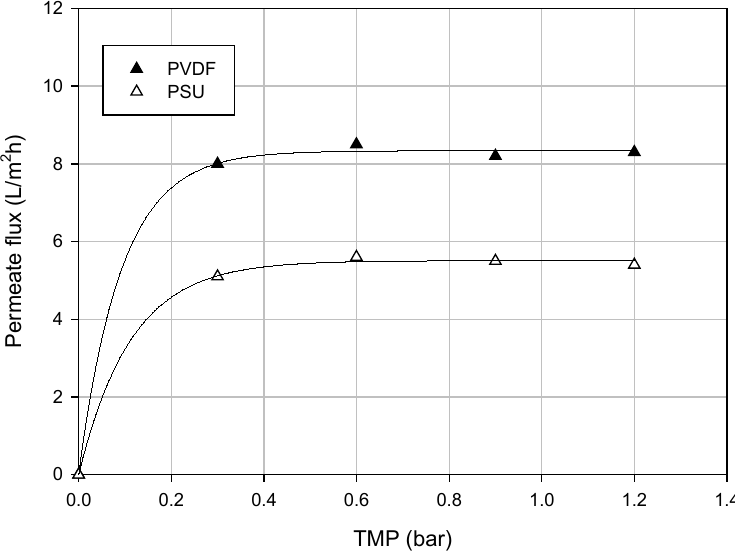
Figure 2. Permeate flux as a function of transmembrane pressures (TMP) for PVDF and PSU HF membranes.